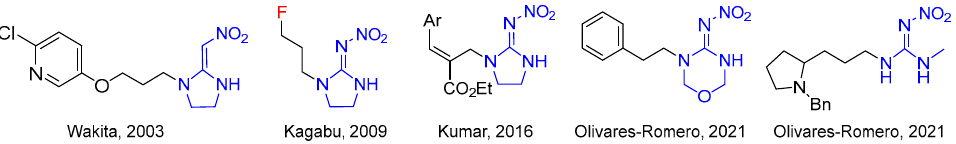
Figure 1. The lead compound NTN32692 and commercialized neonicotinoid insecticides.